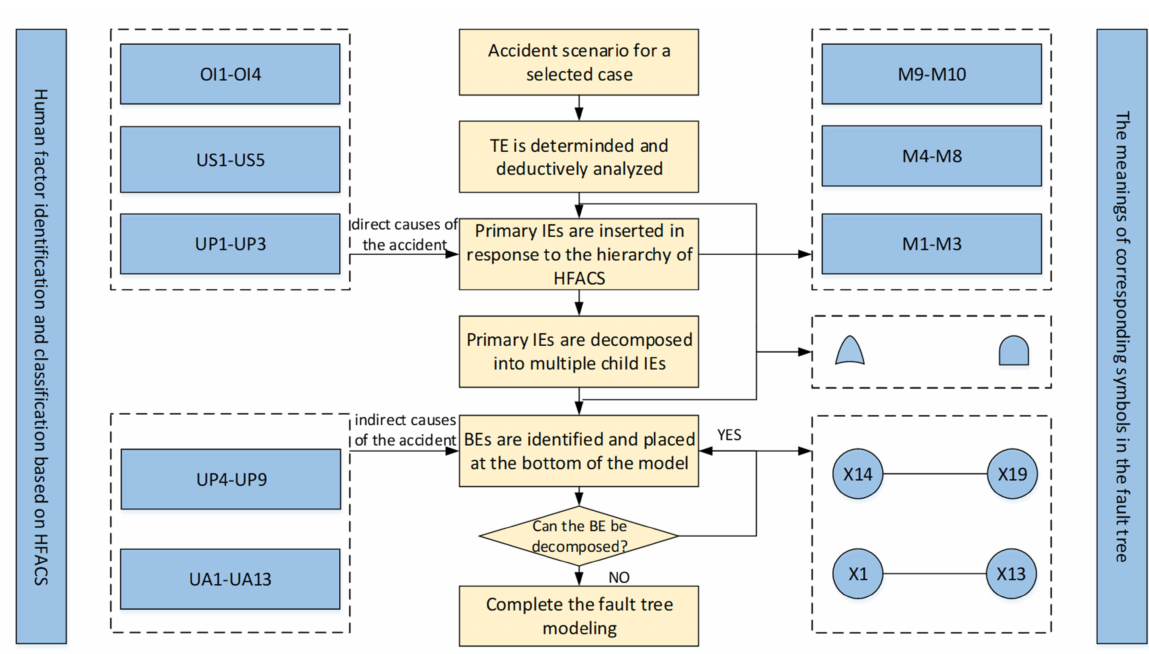
Figure 6. The procedure of fault tree modeling based on